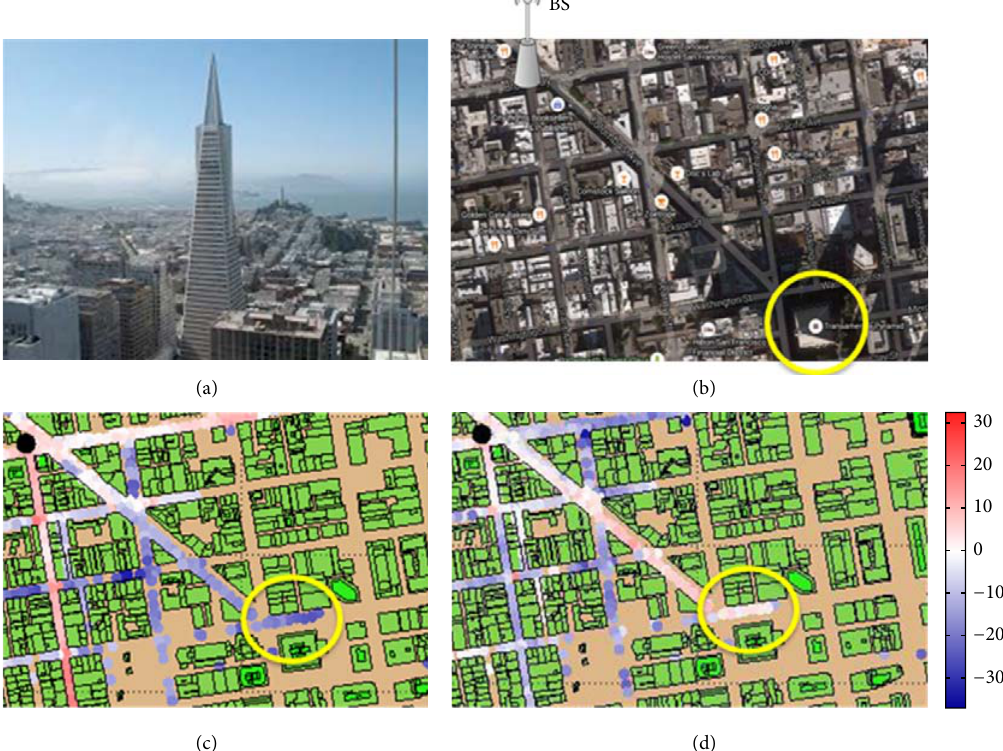
Figure 8: Prediction error with rough (c) and improved (d) walls subdivision in tiles [site A0000DEF; BS position is shown as a black dot].